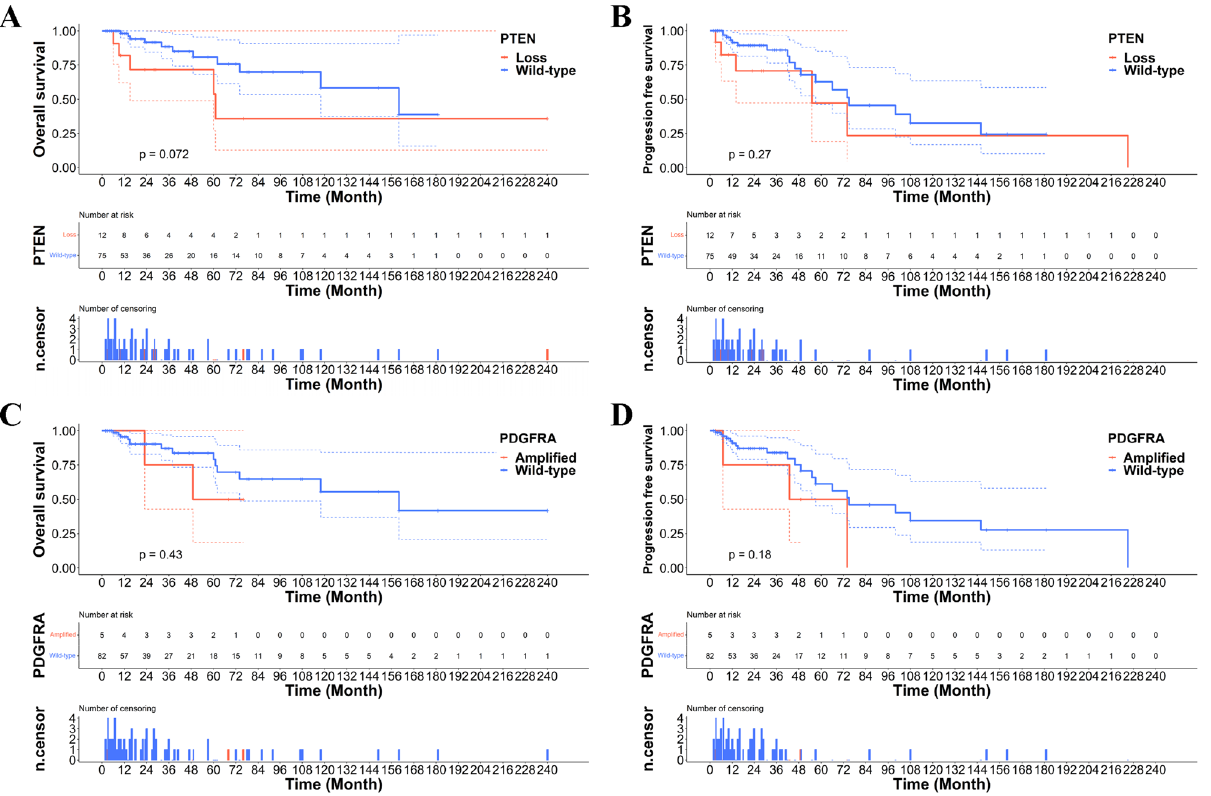
Figure 6. ( A , B ) PTEN deletion and ( C , D ) PDGFRA amplification do not affect the OS and PFS.